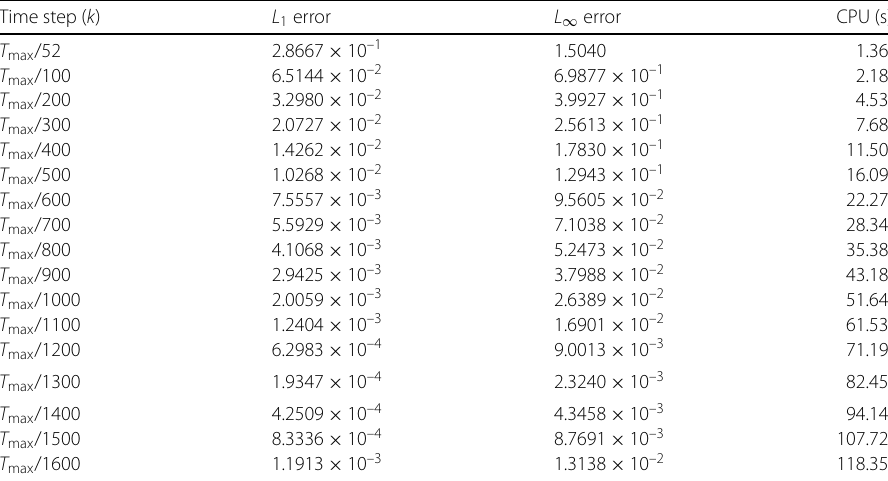
Table 3 L 1 and L ∞ errors and CPU time at some different values of time-step size k for Problem 2 with ρ = 10 4 at time 2.5 × 10 –3 with spatial mesh size h = 0.01 using FTCS scheme,